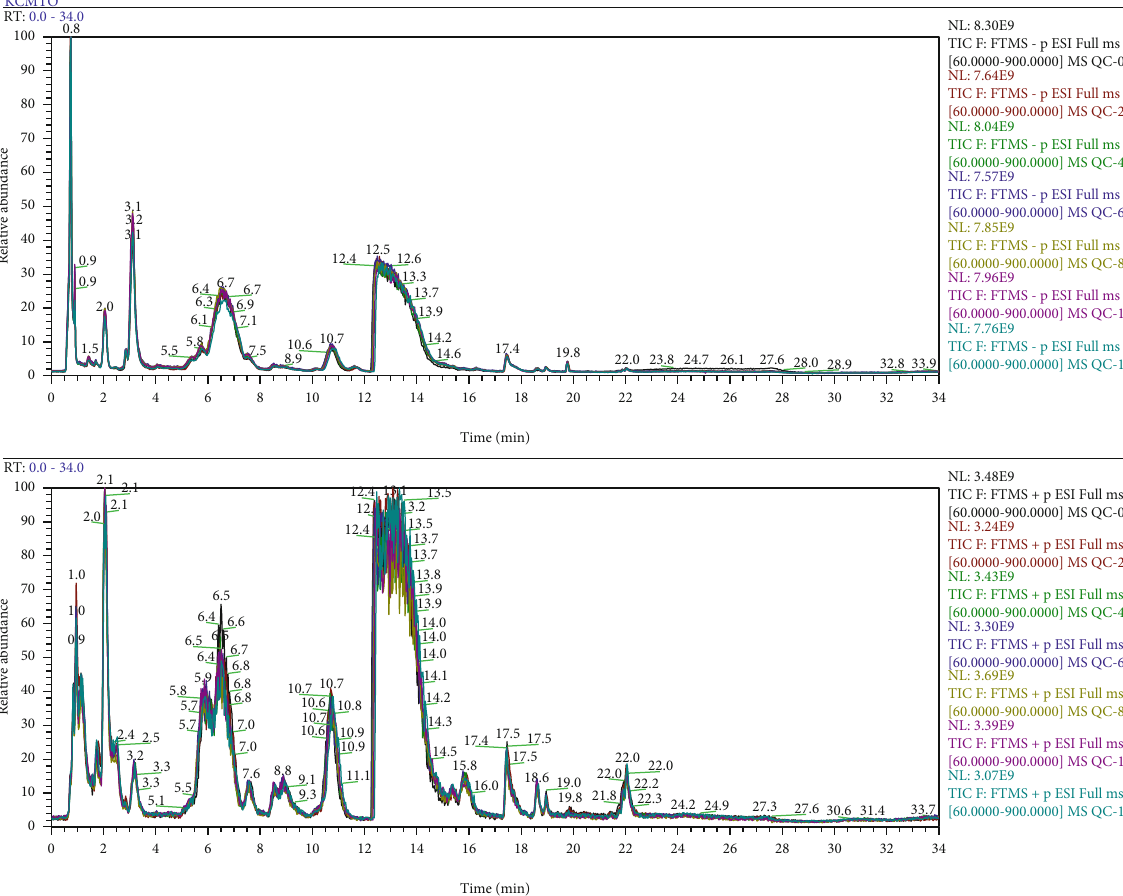
Figure 1: TIC for sequentially selected QC